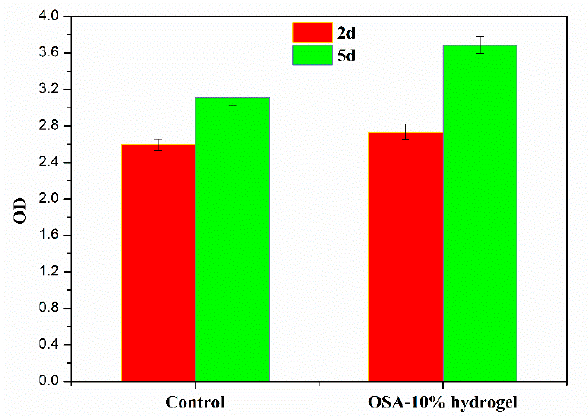
Figure 11. Cell viability of MC3T3-E1 cells cultured on the OSA—10% hydrogel for 2 and 5 days,